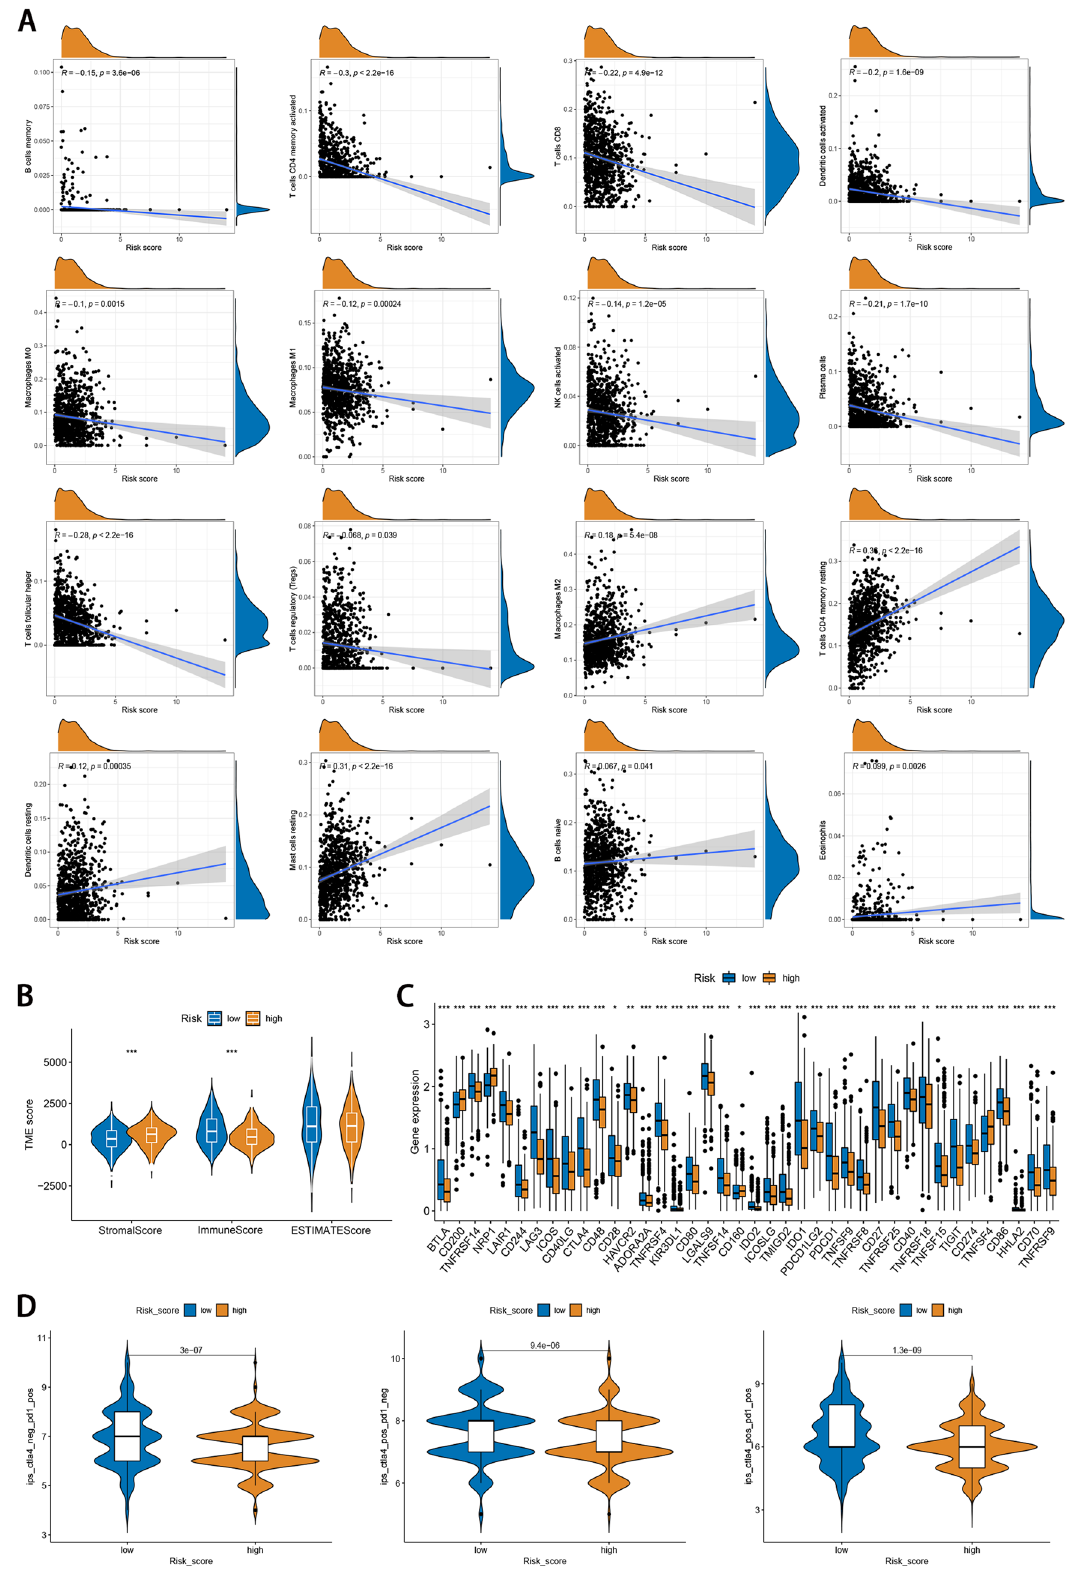
Figure 5. Immune landscape between high- and low-risk groups. ( A ) The infiltration levels of 22 immune cell types in the two risk groups. The spearman correlation coefficient R represents the degree and direction of the correlation between risk score and immune cell types. A positive R-value indicates a positive correlation, a negative R-value indicates a negative correlation, and an absolute value of R equal to zero indicates a zero correlation. ( B ) The relationship between signature and the TME score. ( C ) Difference of immune checkpoint expression between high- and low-risk groups. ( D ) Difference of immunogenicity between high- and low-risk